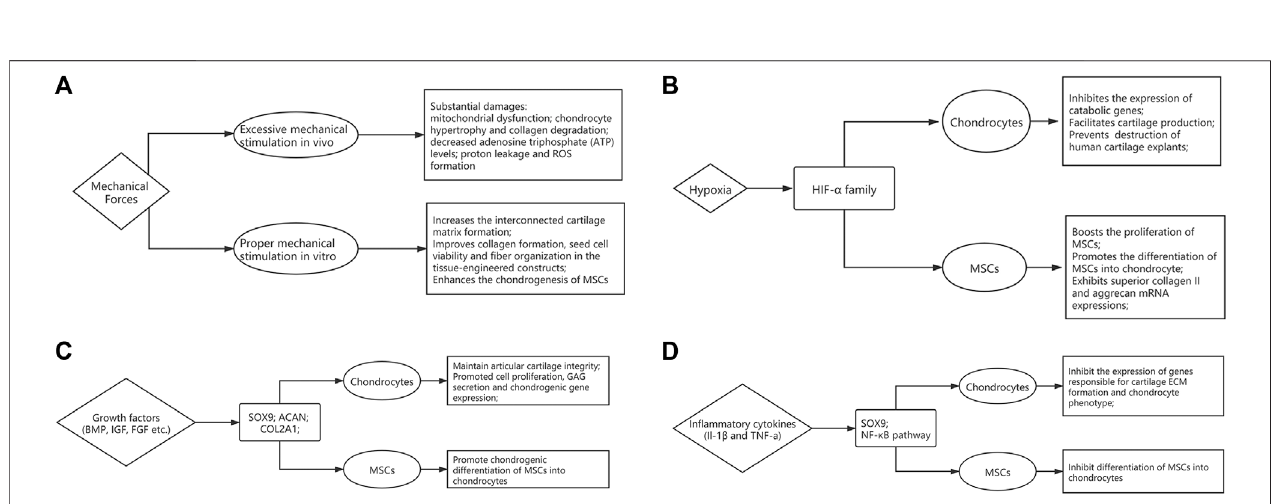
FIGURE 2 | The in fl uence of microenvironmental factors on articular cartilage homeostasis and function. The fl ow-chart describes the effects of (A) mechanical forces, (B) Oxygen tension, (C) growth factors and (D) in fl ammatory cytokines.